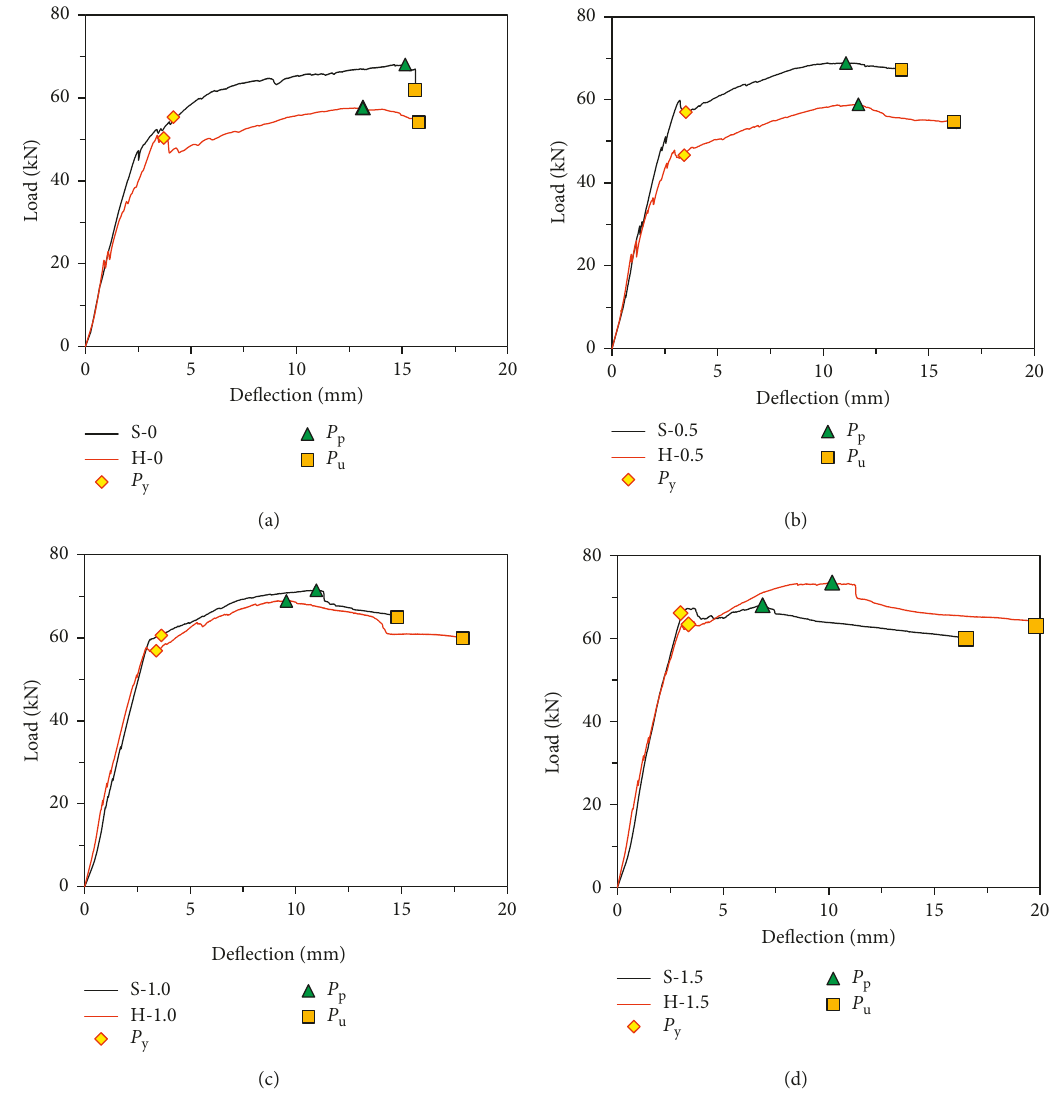
Figure 12: Comparison between load-deflection curves of solid and hollow beams for different fiber